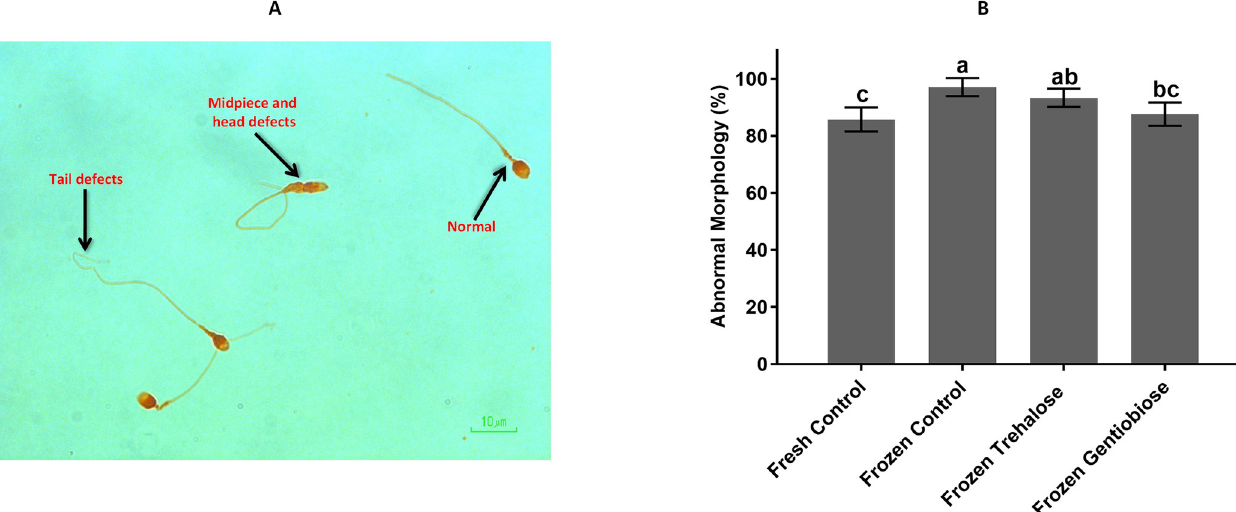
Fig 3. Sperm morphology. Normal and abnormal morphology of sperm as indicated by Papanicolaou staining; the intact cells and defects of the tail, head, and midpiece in sperm are observed (A), and the percentage of abnormal morphology differs in all of the groups (B). The assigned letters a, b and c indicate significant differences (P < 0.05). Values are expressed as mean ± SD, Tukey test; n = 25.